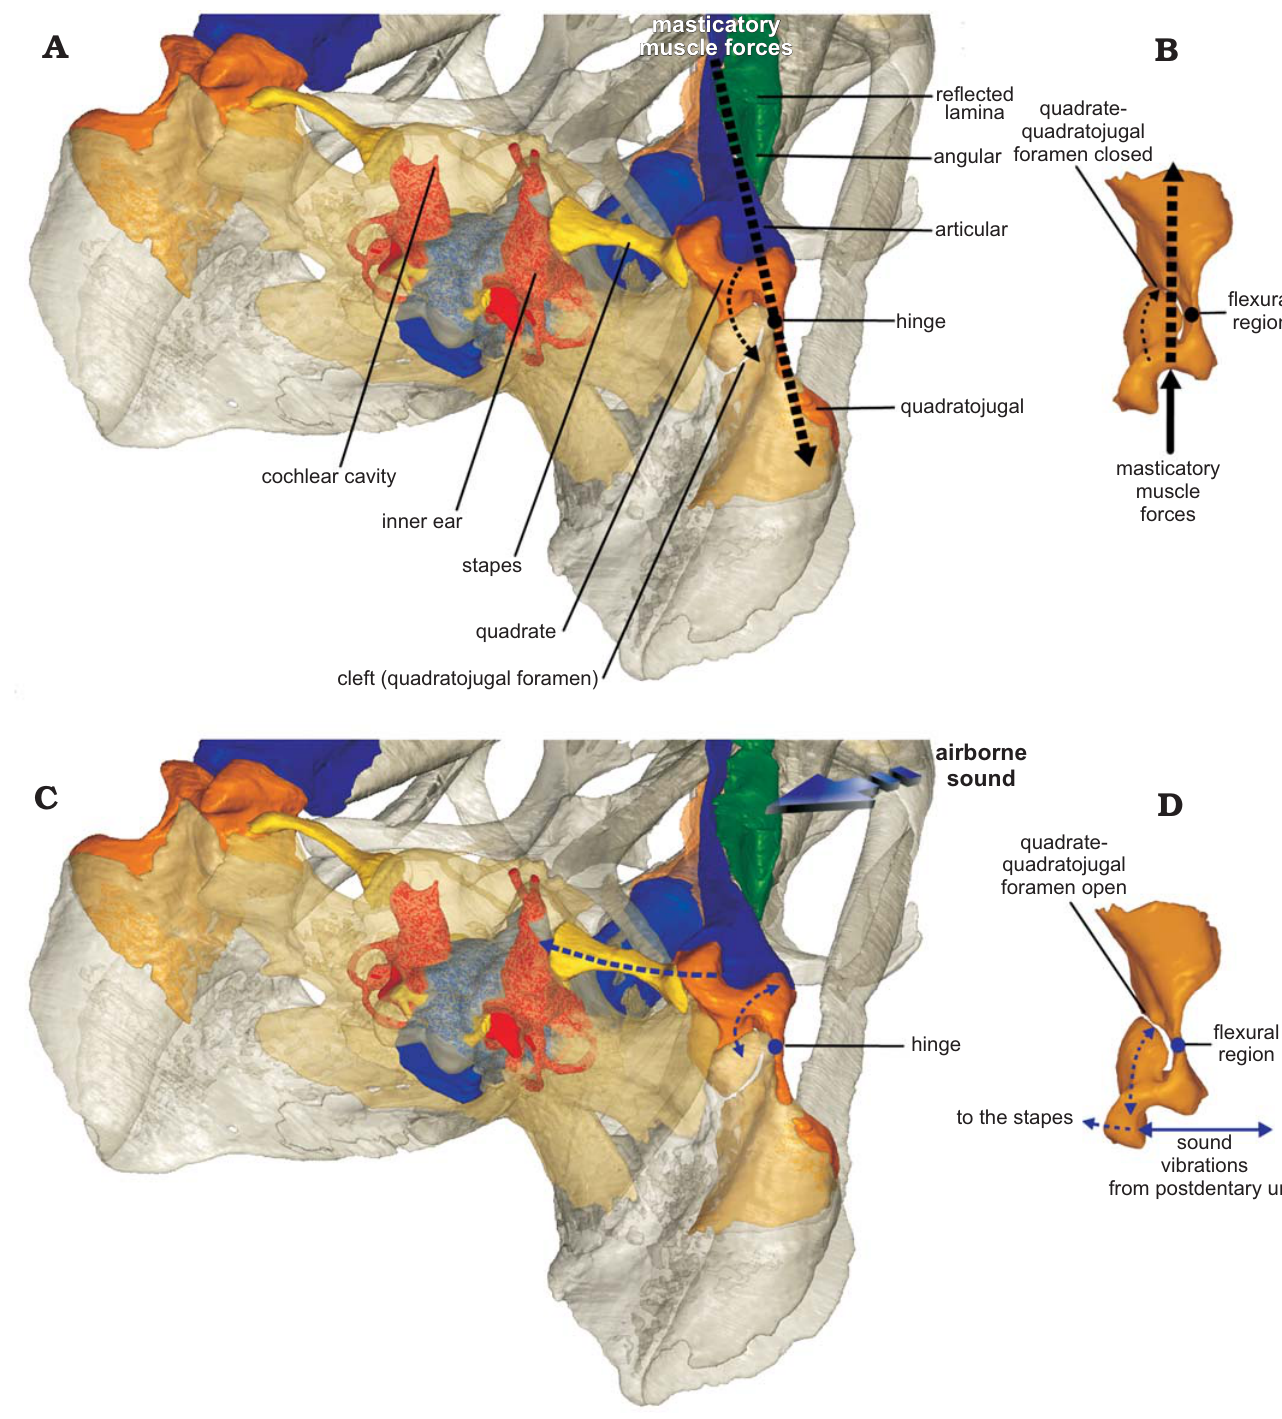
Fig. 7. Dual function of the auditory and masticatory apparatus of the non-mammalian synapsid Pristerodon mackayi Huxley, 1868 (MB.R.985) from the Late Permian of Biesjespoort, South Africa. A . Auditory region in posteroventral view showing the mechanics of the jaw articulations during mastication. B . Masticatory forces at the quadrate-quadratojugal complex (in posterior view). C . Auditory region in posteroventral view showing the mechanics of sound conduction. D . Mechanics of sound conduction of the quadrate-quadratojugal complex in posterior view. When the jaw muscles were relaxed, the reflected lamina and its putative tympanic membrane would receive the airborne sound, which would cause medio-lateral vibrations of the postdentary bones (although in small amplitude). The sound vibration was transmitted via the jaw hinge and the horizontal stapes to the inner ear. During the vibration, the quadrate is mobile at its ball and socket joint to the cranium, as permitted by a very thin bony connection with the quadratojugal. However, when the jaw musculature contracted during mastication, the quadrate was immobilized, it was strained by masticatory force and oppressed against the quadratoju- gal and the cleft between the quadrate and the quadratojugal is closed. During the active mastication, hearing was likely suspended, or reduced to a very low sensitivity if feasible at all. Not to